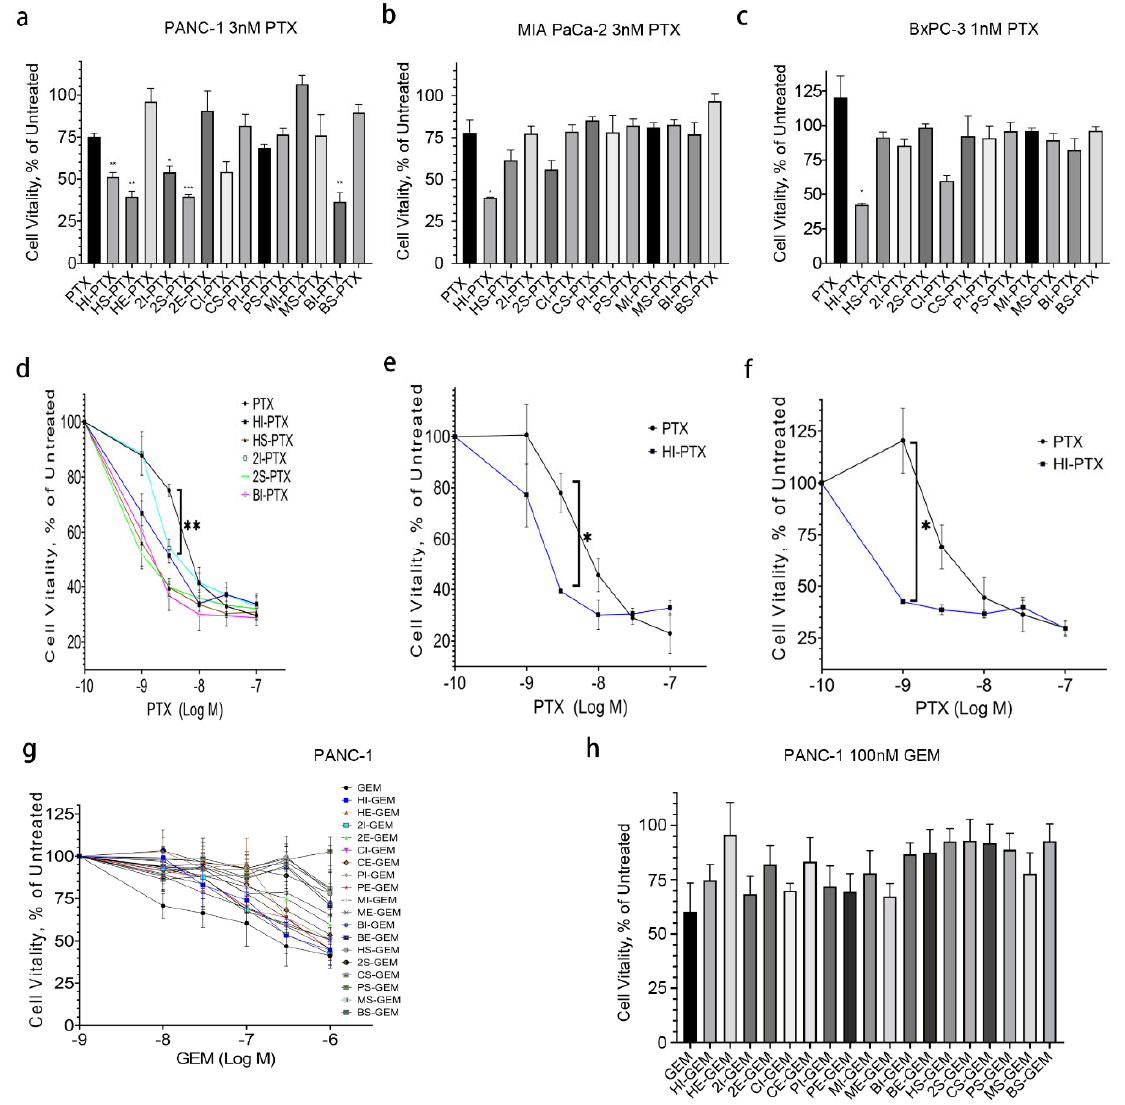
Figure 2. HI ‐ PTX is more cytotoxic than other EV drugs. ( a , d ) Cell vitality of PANC − 1 cells treated with equivalent of 3 nM PTX and 1 to 100 nM EV − PTX for 72 h; ( b , e ) Cell vitality of MIA PaCa − 2 cells treated with equivalent of 3 nM PTX and 1 to 100 nM EV − PTX for 72 h; ( c , f ) Cell vitality in BxPC − 3 cells treated with equivalent of 1 nM PTX or 1 to 100 nM EV − PTX for 72 h; ( g , h ) Cell vitality of PANC − 1 cells treated with equivalent of 100 nM GEM or 10 nM to 1 μ M EV − GEM for 72 h. The